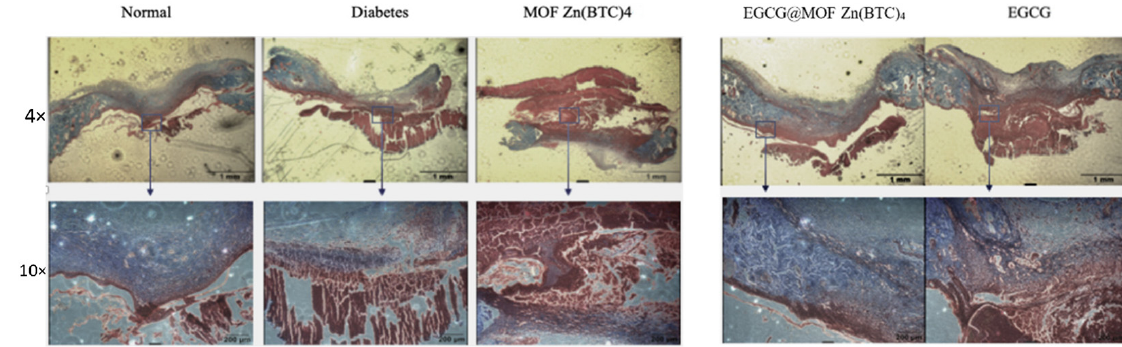
Figure 11. Collagen